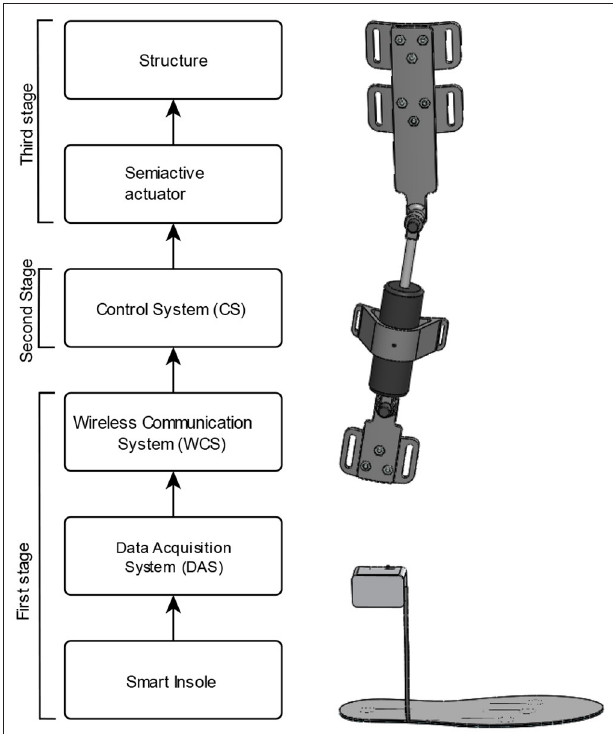
FIGURE 1 | Composition of the orthosis using a semi-active actuator.